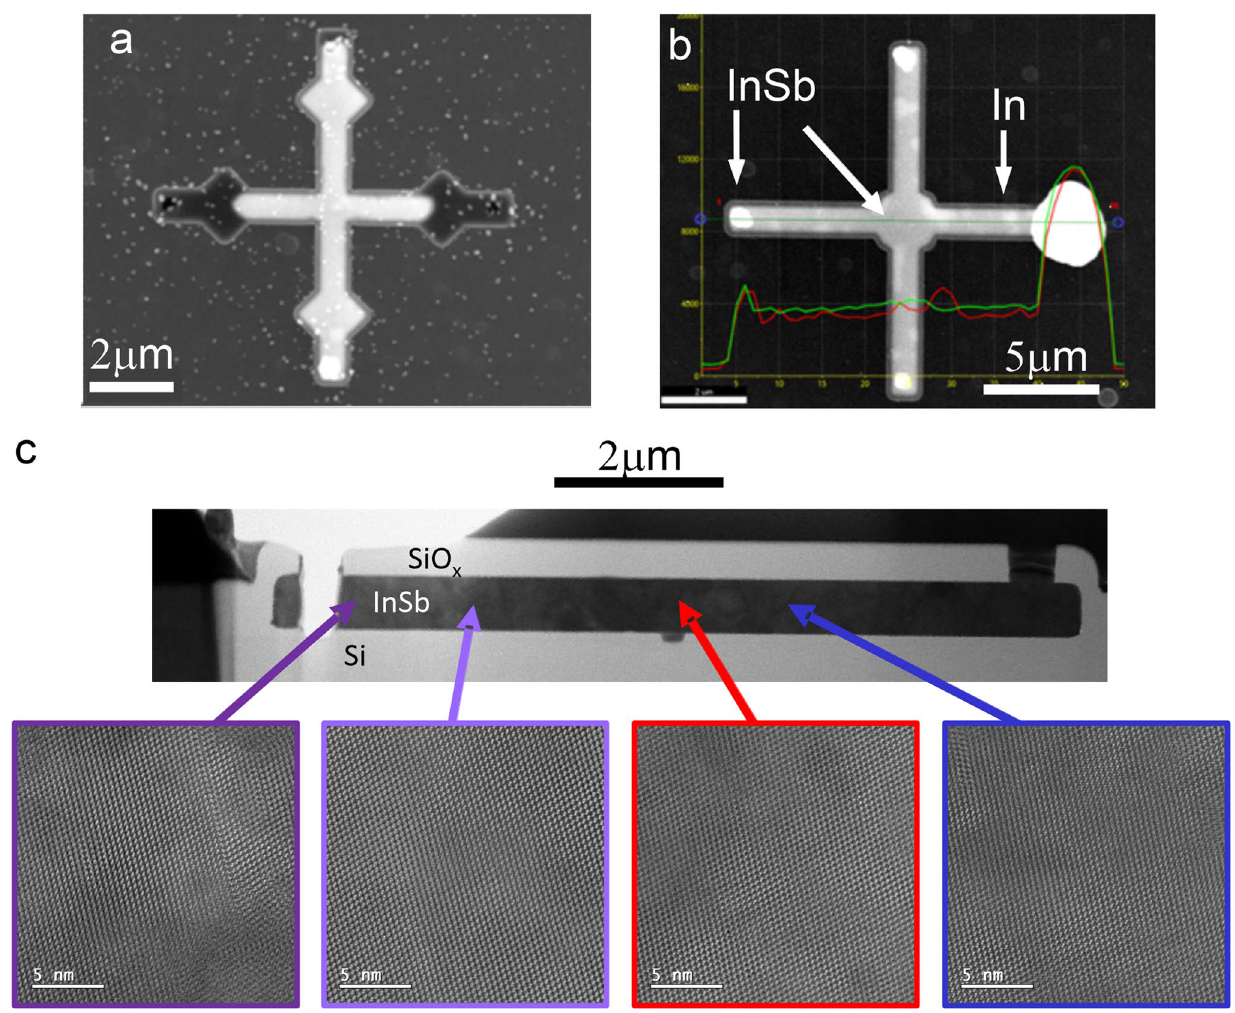
Fig. 7 Analysis of In electrodeposit saturated with antimony above the InSb melting temperature. a Top-view SEM image showing uniform contrast of the InSb. b Example of a non-uniform sample, revealing segments of In (bright) and InSb (darker) with different contrast. c BF- TEM overview of an InSb sample cross section and corresponding high-resolution lattice